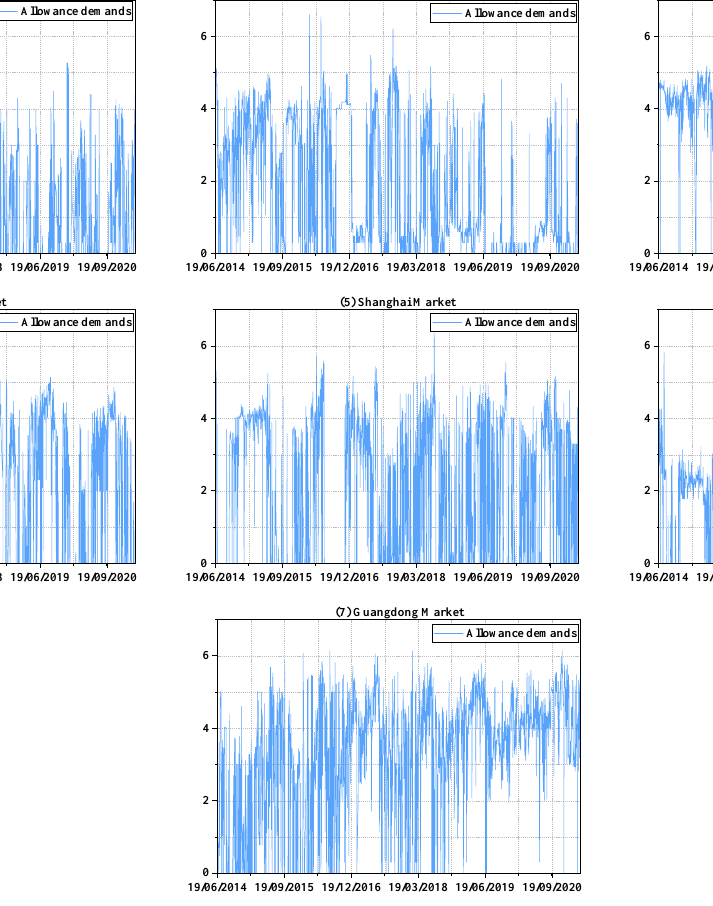
Figure 1. The dynamics of logarithmic trading volumes in seven